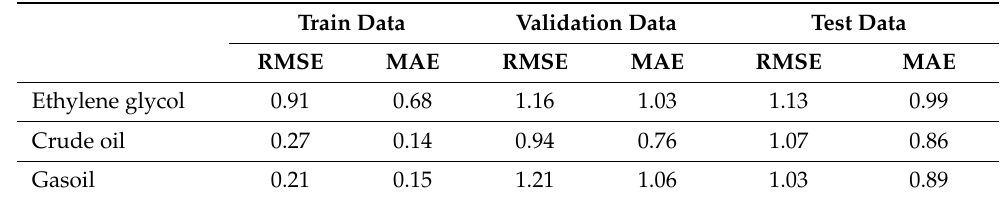
Figure 8. Operation of the designed neural network to detect the volumetric ratio of gasoil ( a ) train data, ( b ) validation data, and ( c ) test data. Table 2. The estimated error for established networks.